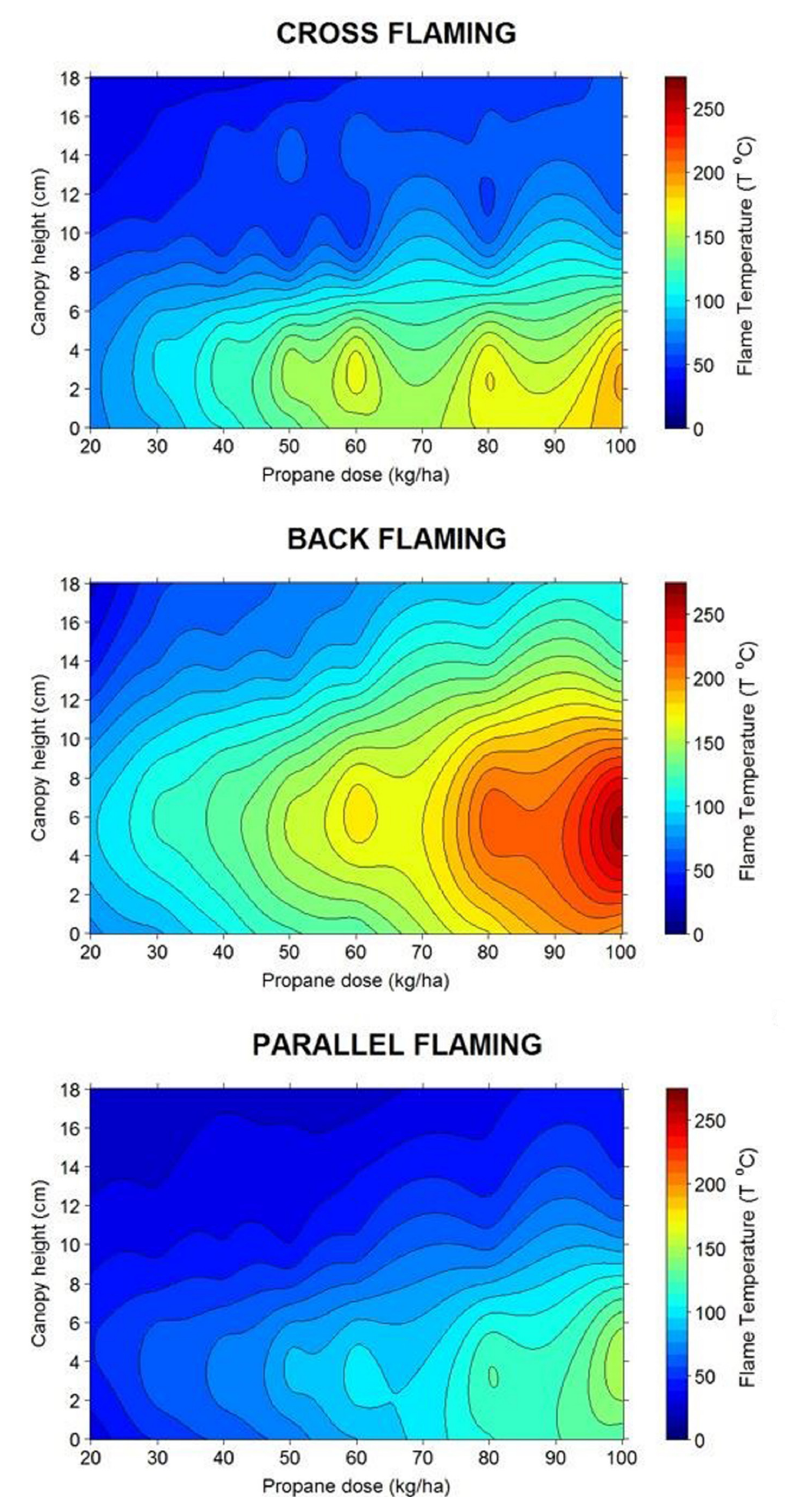
Figure 4. Within-row flame temperature distribution for cross, back, and parallel burner orientation at different propane doses (kg/ha) and canopy heights (cm) during the field testing of the flame cultivator.